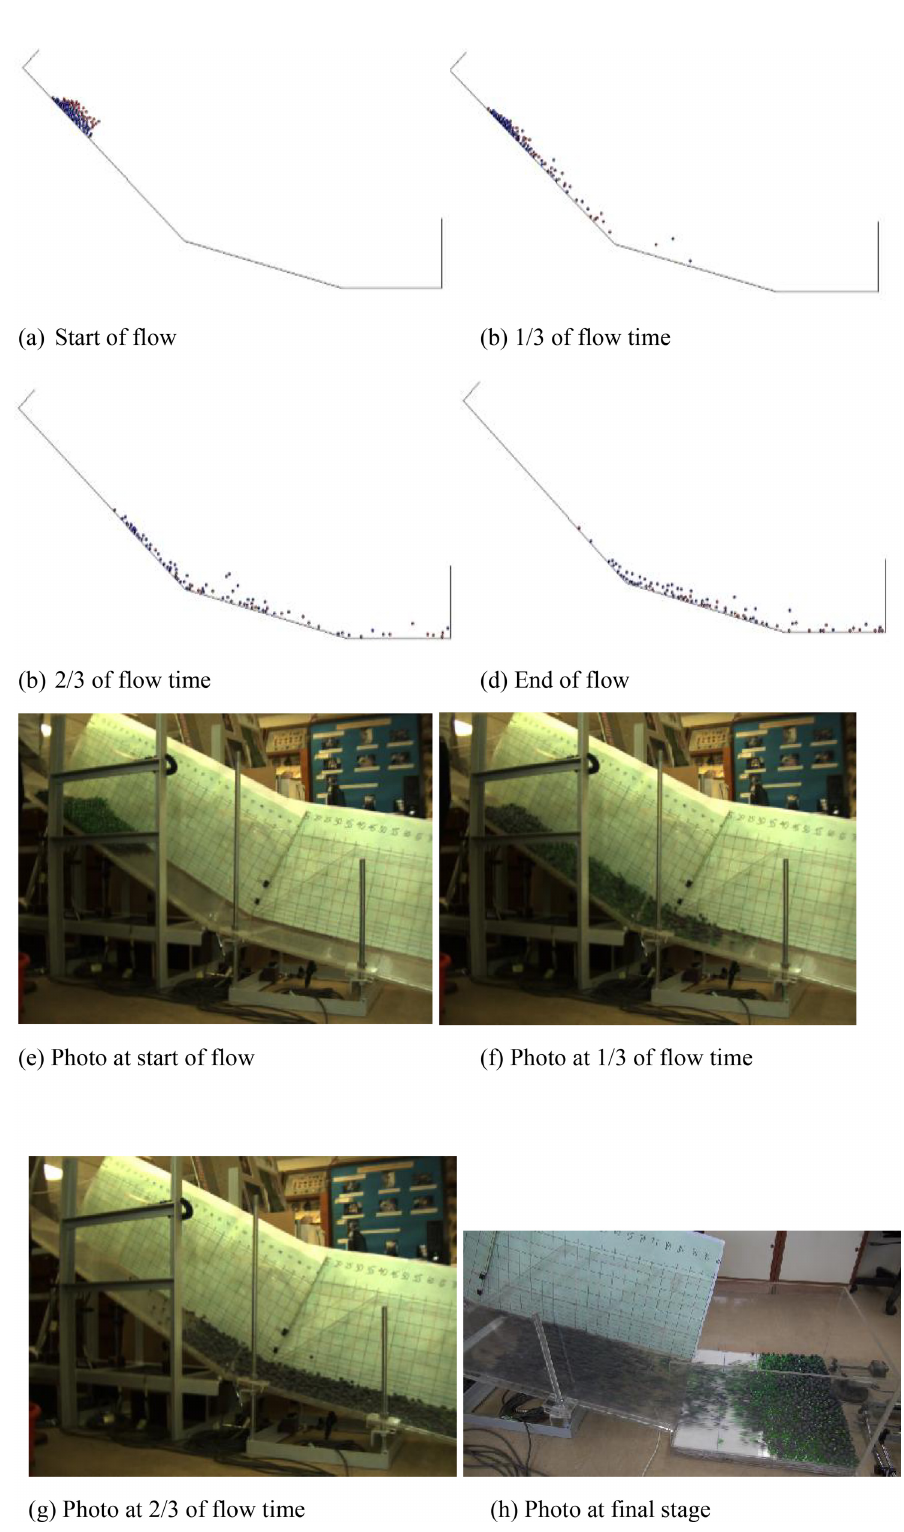
Figure 10. Flow pattern of multi-size particle flow composed of black plastic balls and green glass